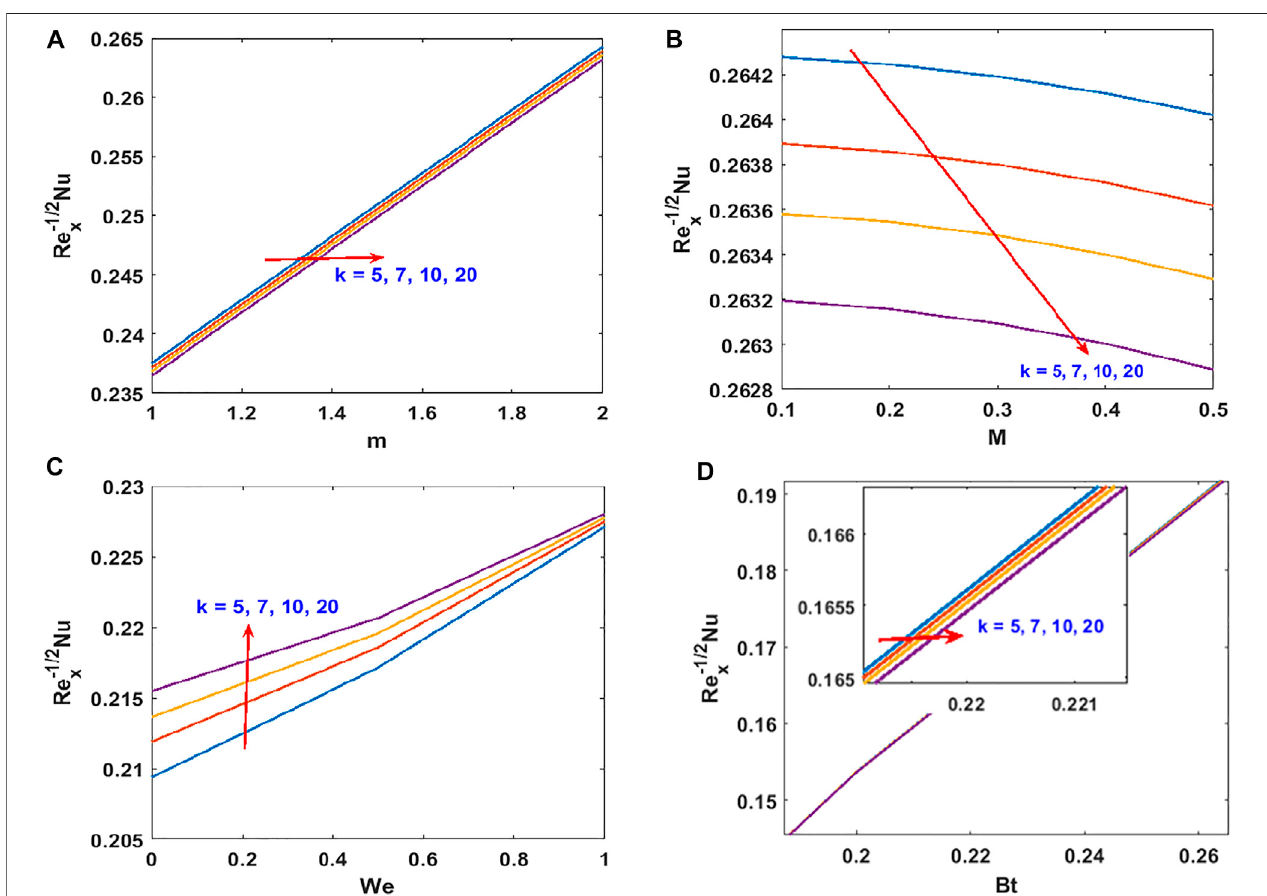
FIGURE 8 | Variation of heat transfer on curvature parameter k against m, M, We, and